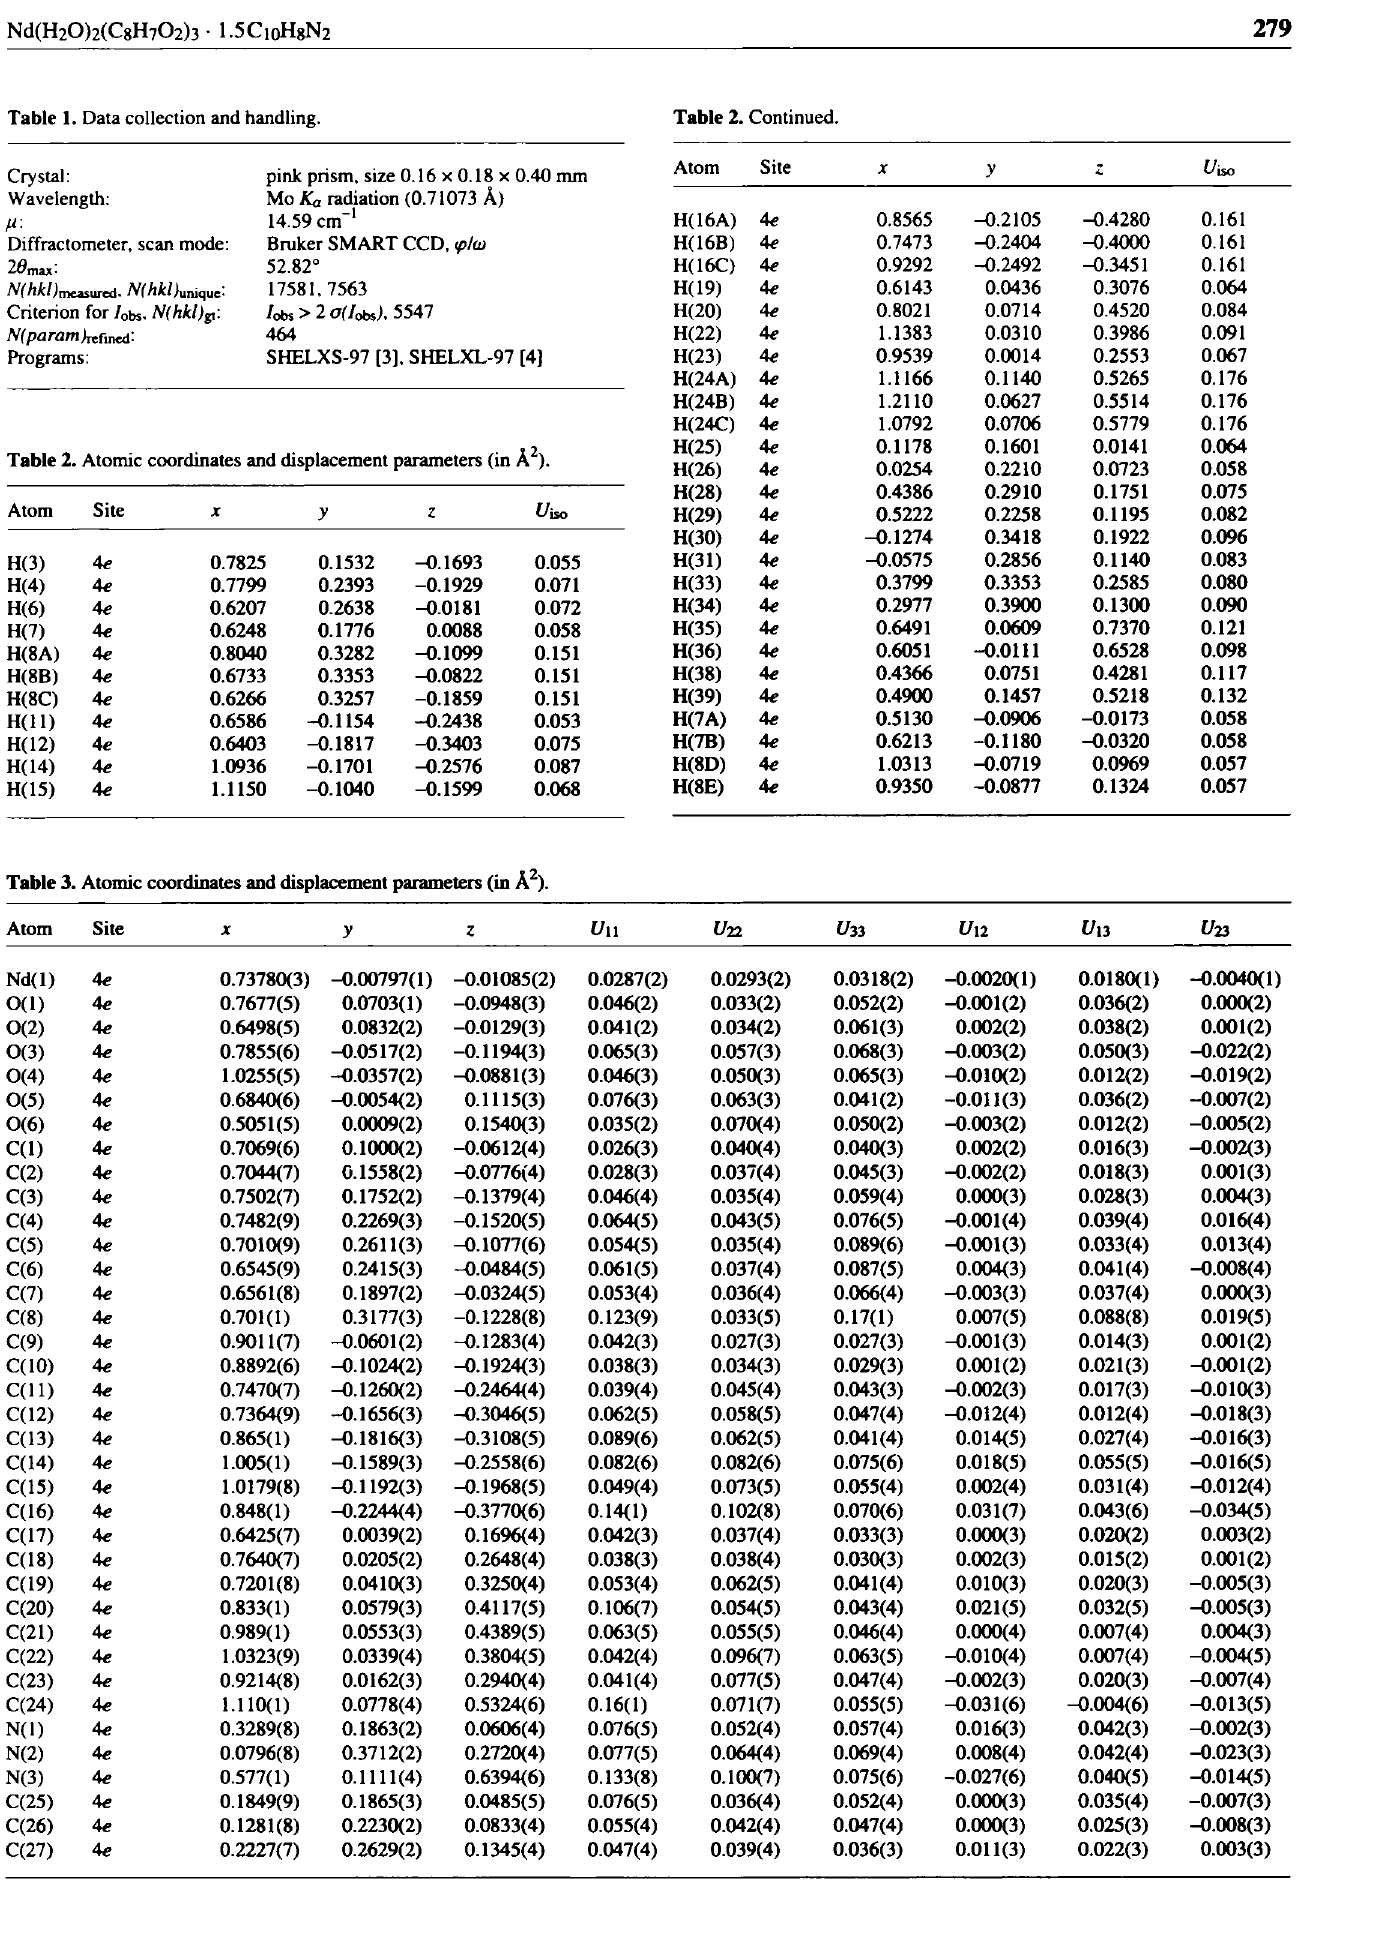
Table 3. Atomic coordinates and displacement parameters (in Â 2